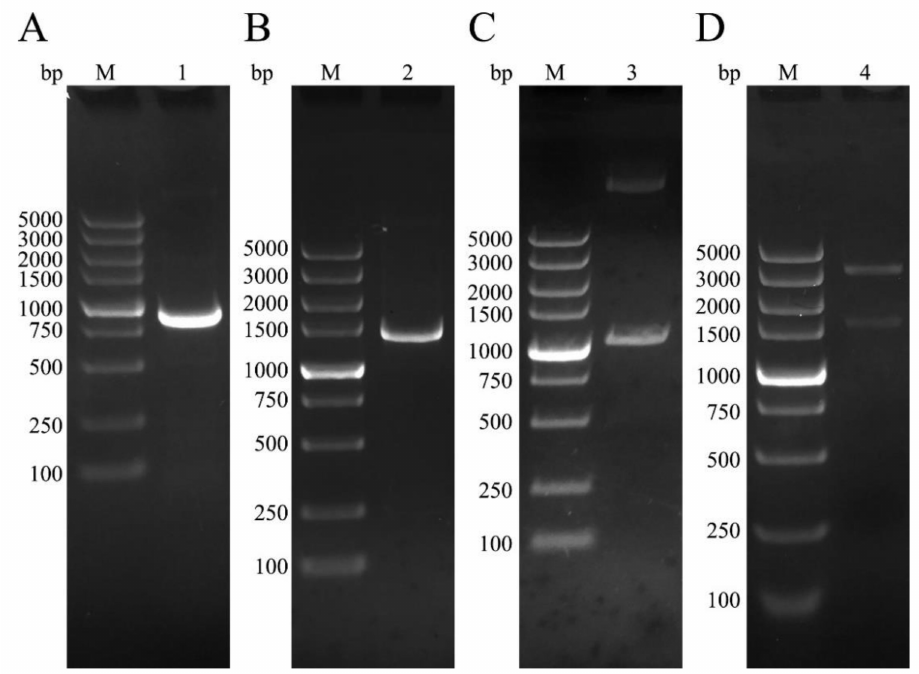
Figure 1. Gene cloning and vector construction. ( A ) RT-PCR amplification of ntmEmROM5. M, DNA molecular weight standard of DL5000. Lane 1, amplification products of ntmEmROM5 (963 bp). ( B ) RT-PCR amplification of EmROM5. M, DNA molecular weight standard of DL2000. Lane